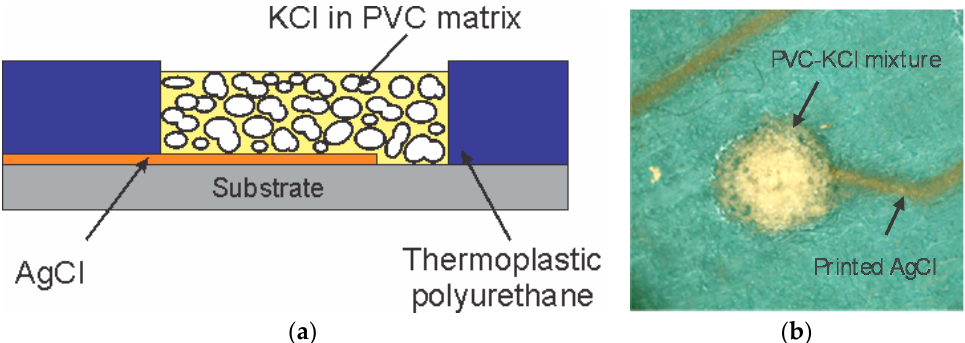
Figure 1. ( a ) Illustration of cross section and ( b ) top view photo of a solid-contact reference